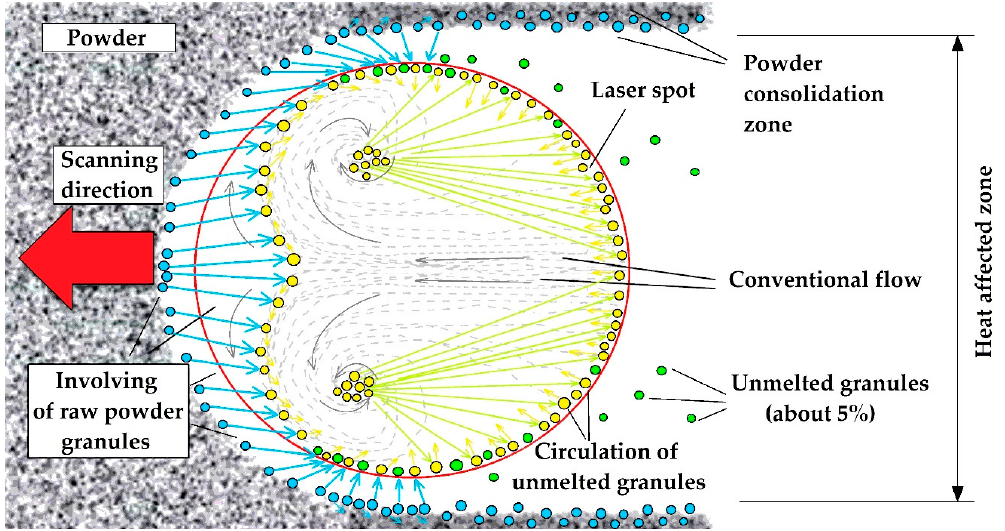
Figure 14. Analytical model of the convectional flows and involvement of the raw powder into the melting process of the molten pool during selective laser melting. melting process of the molten pool during selective laser